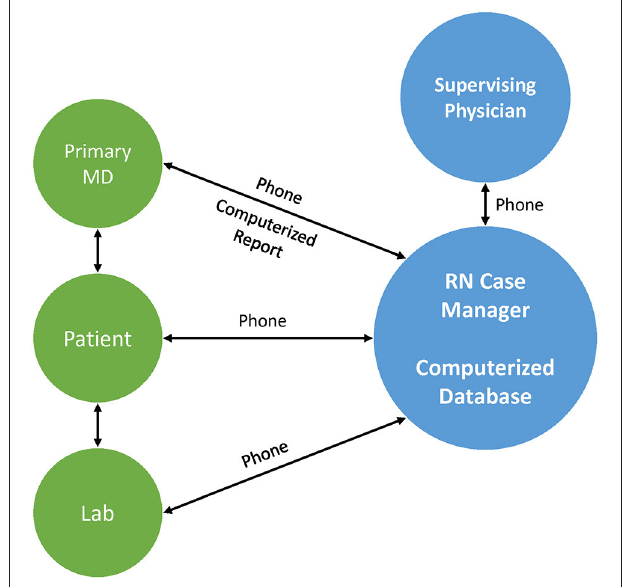
FIGURE 1 | The MULTIFIT model of home-based cardiac